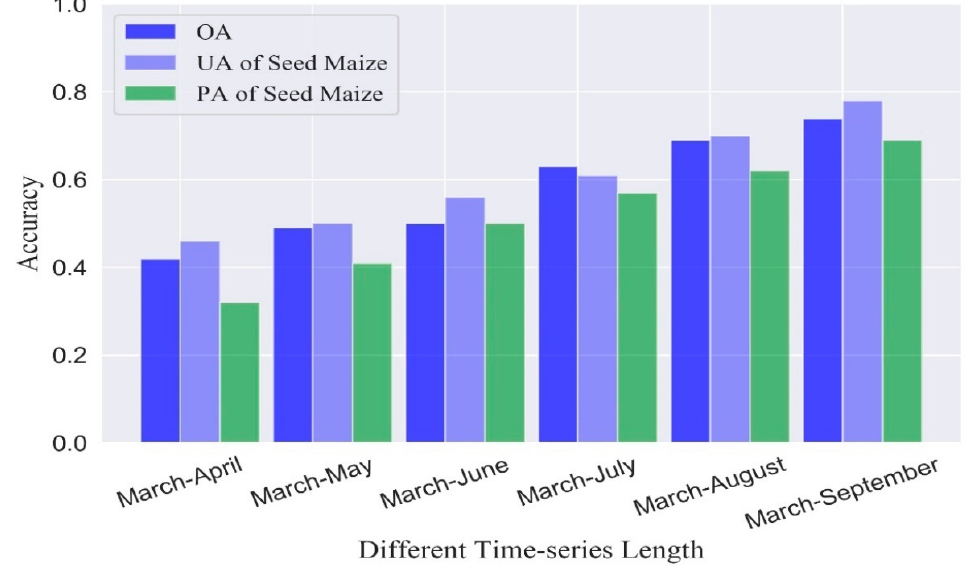
Figure 13. Overall accuracy, PA, and UA of seed maize based on new samples for different time series lengths.